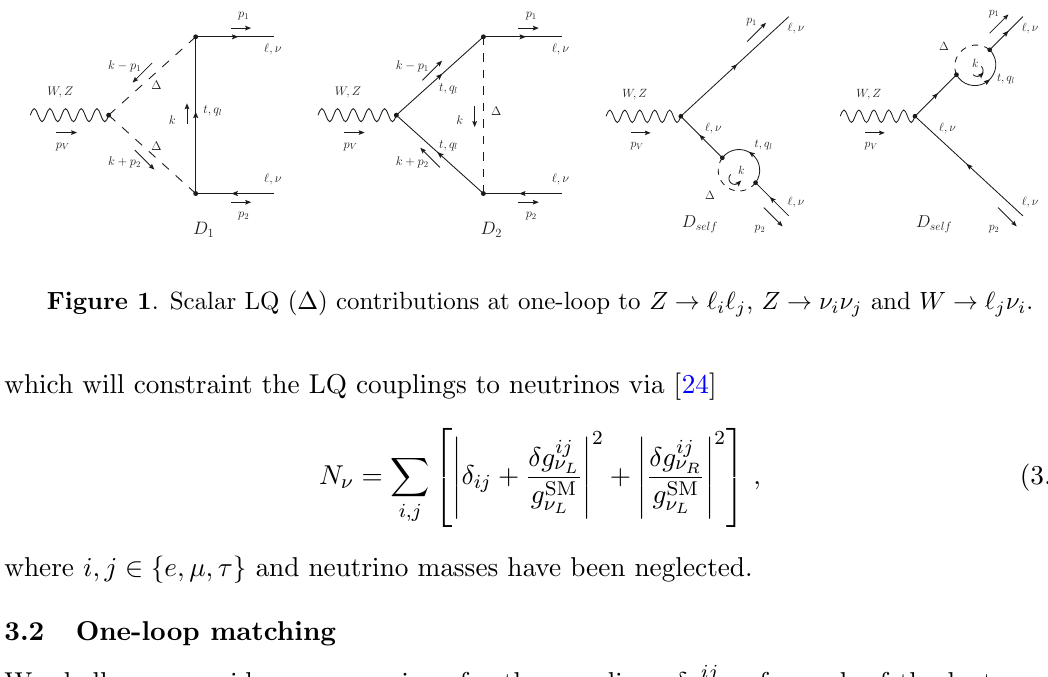
Figure 1 . Scalar LQ ((cid:1)) contributions at one-loop to Z